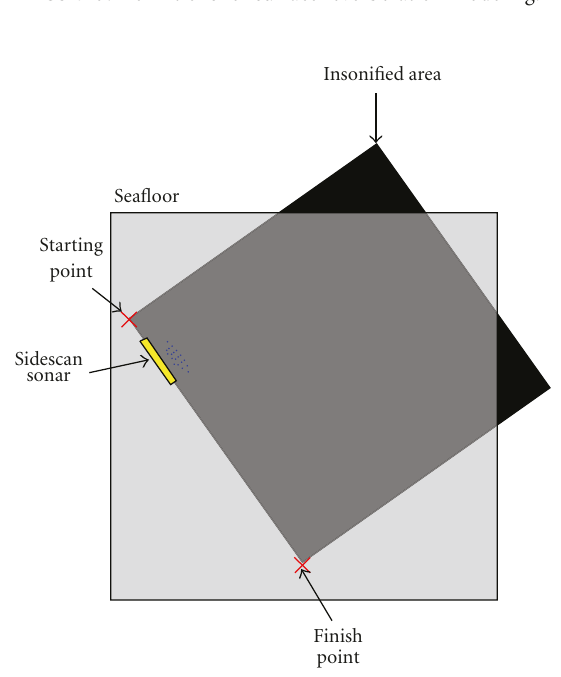
Figure 6: The trajectory of the sonar platform can be placed into the 3D